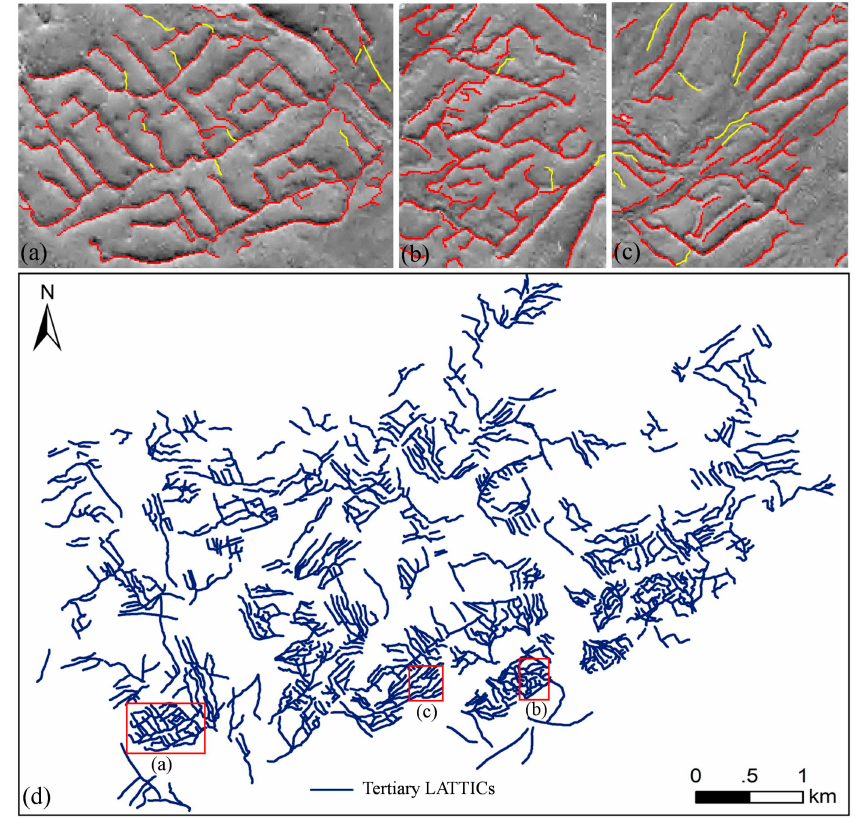
Figure 9. ( a – c ) Results of auto-extracting tertiary LATTICs from the experimental image ( a ); and Test Images I ( b ); and II ( c ); and automatic extraction results of tertiary LATTICs for the whole Miran site ( d